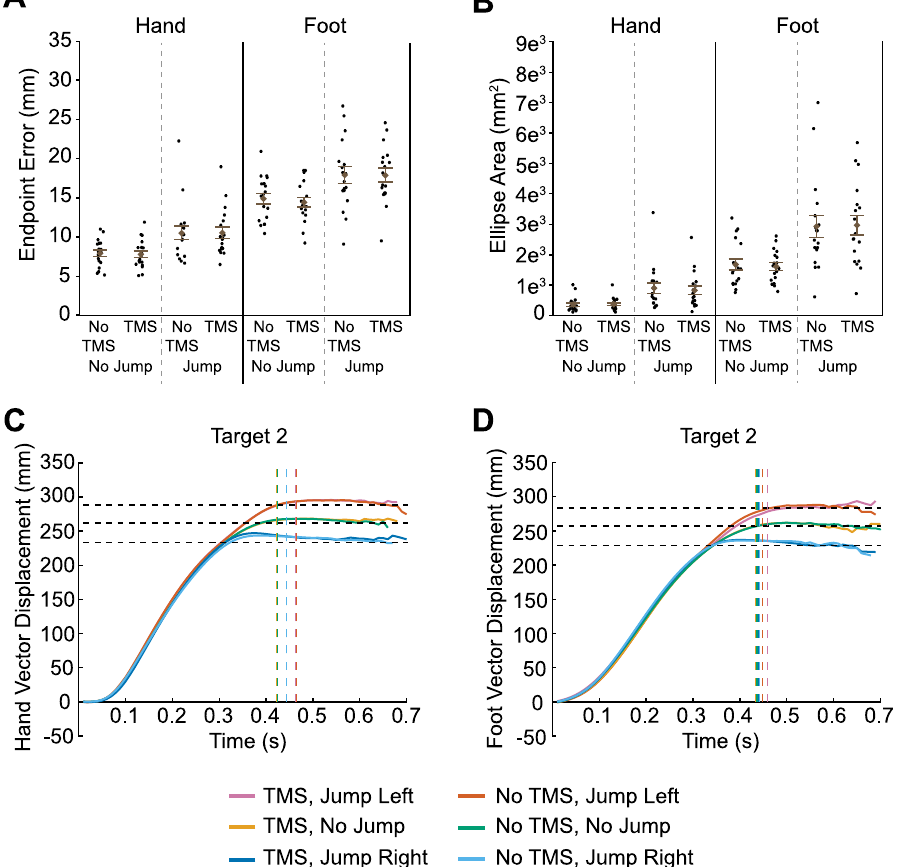
Fig 6. Results of sham stimulation. Euclidean endpoint error (A) and ellipse area based on endpoint error (B) for hand and foot reaches across all conditions. Filled circles represent mean data from each individual participant. Group mean ± SE is also shown. Hand (C) and foot (D) trajectories towards target two are shown for each condition. Horizontal dashed lines represent the final position of the target (jump left, no jump, and jump right). Vertical dashed lines indicate the average time at which the finger or toe contacted the touchscreen for each